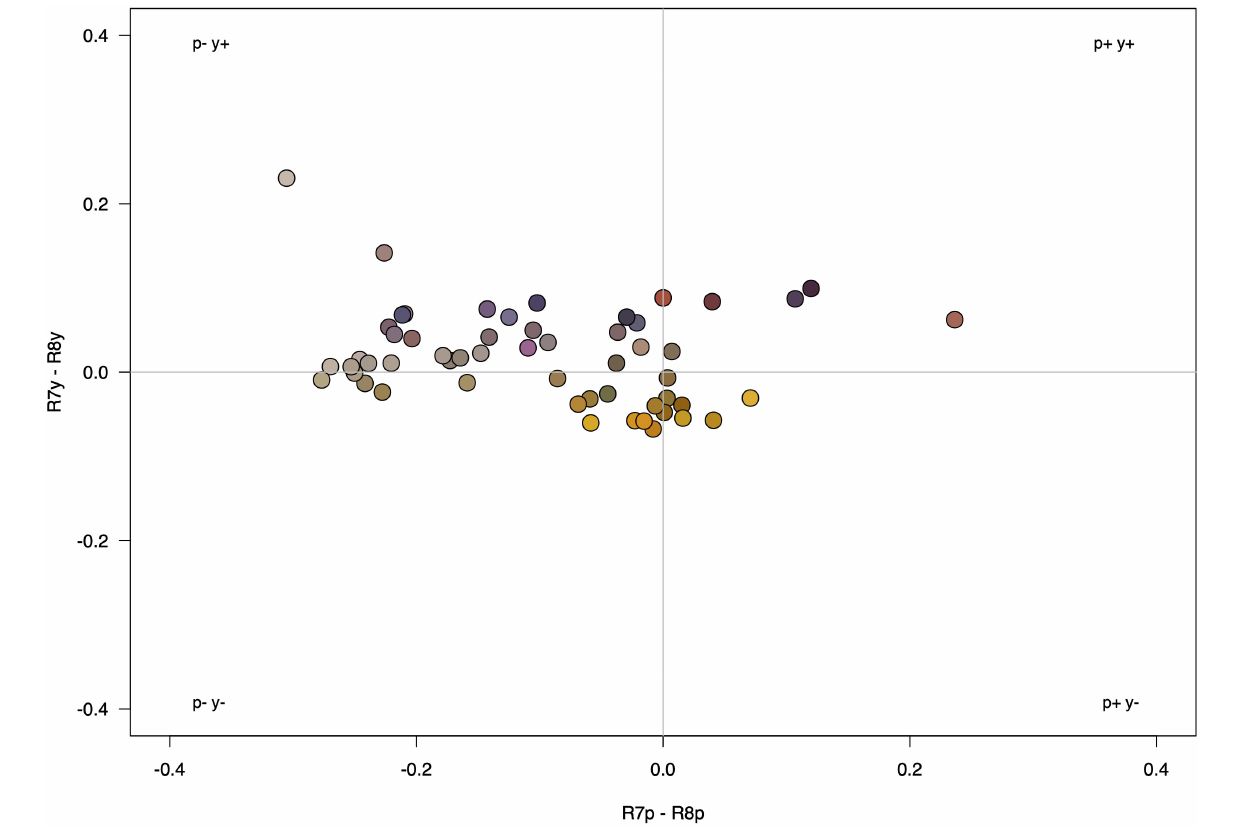
community type (observed vs. null) and seep index for